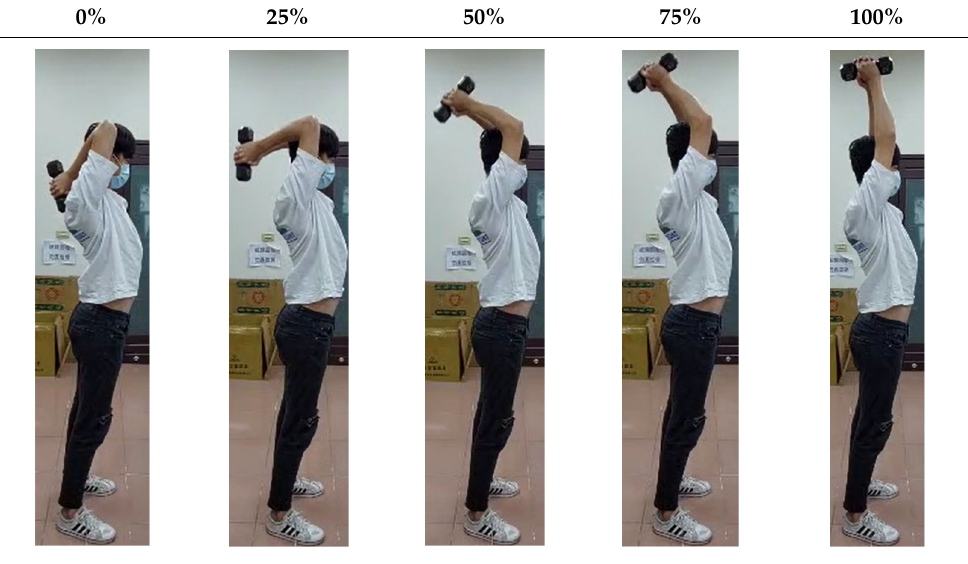
Table 3. The motion track recorded after converting the video database to images.